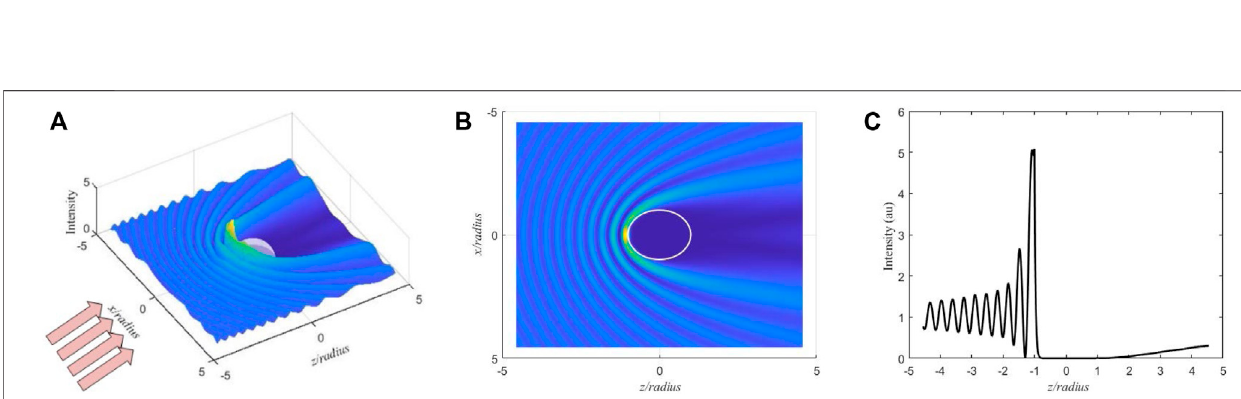
FIGURE5| Thedistributionofinternalandnear fi eldswith f i =2.1 GHz, f p =4 GHz,and ] c =3 GHz: (A) three-dimensionalpattern; (B) the fi eldintheplane x – z ;and (C) the intensity along the z- axis.